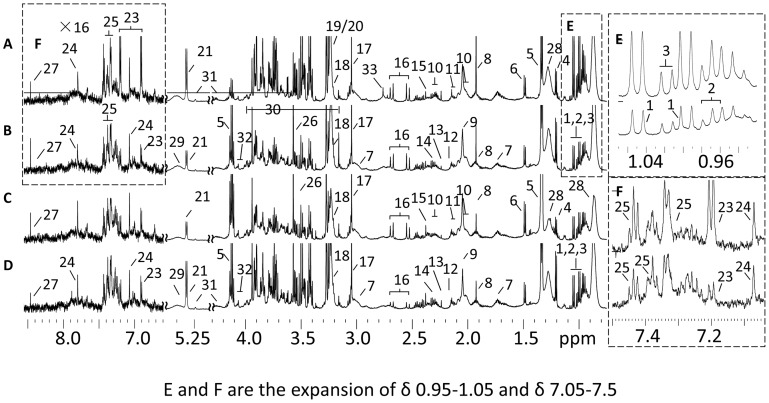
Typical 600-MHz 1H NMR CPMG spectra of plasma.A–D, represent controls (A) and calves infected with M. bovis (B), H37Rv (C), and M. tb1458 (D), respectively. The spectral regions of δ 6.5–8.5 were expanded 16 times. Keys: 1, valine; 2, leucine; 3, isoleucine; 4, 3-hydroxybutyrate; 5, lactate; 6, alanine; 7, lysine; 8, acetate; 9, N-acetyl-glycoprotein; 10, glutamate; 11, glutamine; 12, methionine; 13, acetone; 14, acetoacetate; 15, pyruvate; 16, citrate; 17, creatine; 18, choline; 19, phosphorylcholine; 20, glycerylphosphorylcholine; 21, glucose; 22, fumarate; 23, tyrosine; 24, 1-methyl-histidine; 25, phenylalanine; 26, glycine; 27, formate; 28, lipid; 29, unsaturated fatty acid; 30, glucose and amino acids a-CH resonances; 31. Triacylglycerol; 32, myo-inositol; and 33, unknown.